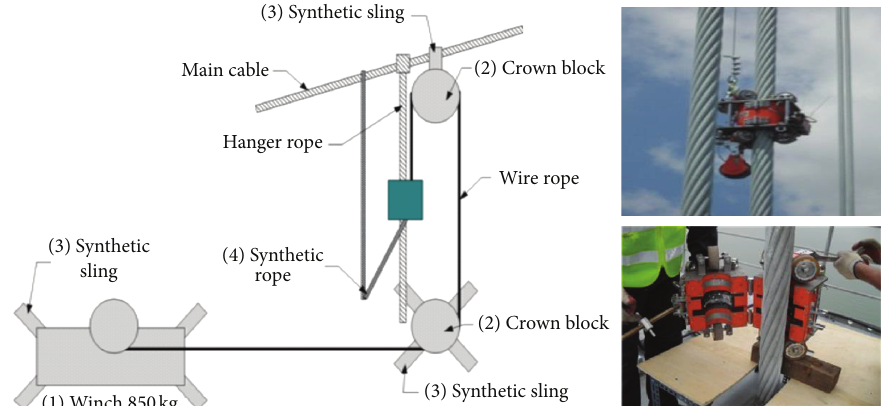
Figure 7: MFL system applied in hanger cable inspection for Yeong-Jong Bridge in Korea [32].